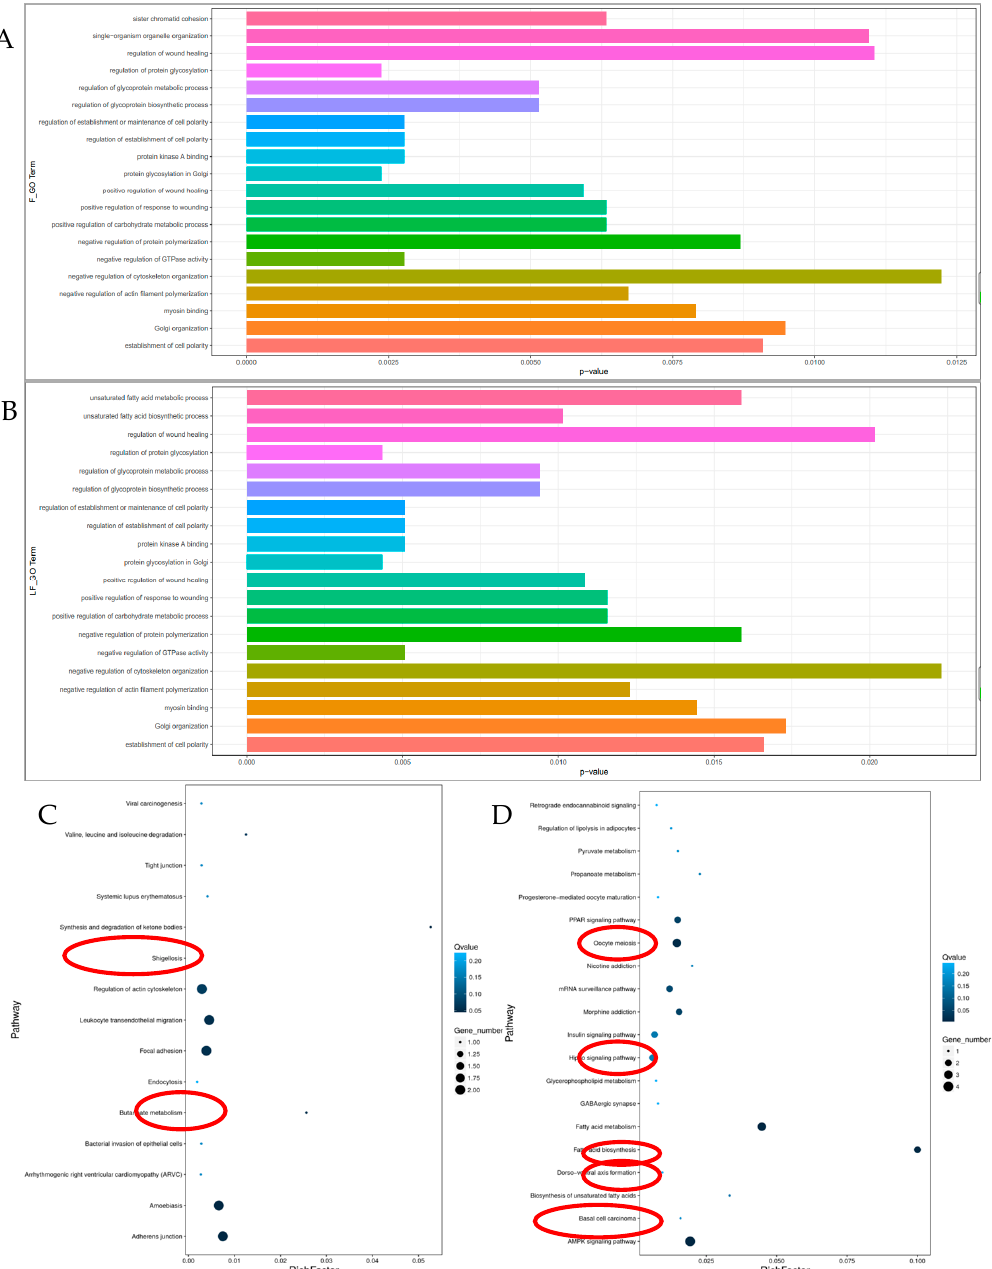
Figure 3. Functional analyses of the host genes of the differentially expressed circRNAs. ( A ) GO analysis of the host genes of the differential circRNAs in dorsal adipose tissue. ( B ) GO analysis of the host genes of the differential circRNAs in abdominal fat tissue. ( C ) KEGG analysis of the host genes of the differential circRNAs in dorsal adipose tissue. ( D ) KEGG analysis of the host genes of the differential circRNAs in abdominal fat tissue. Some pathways associated with fat deposition are circled in red.